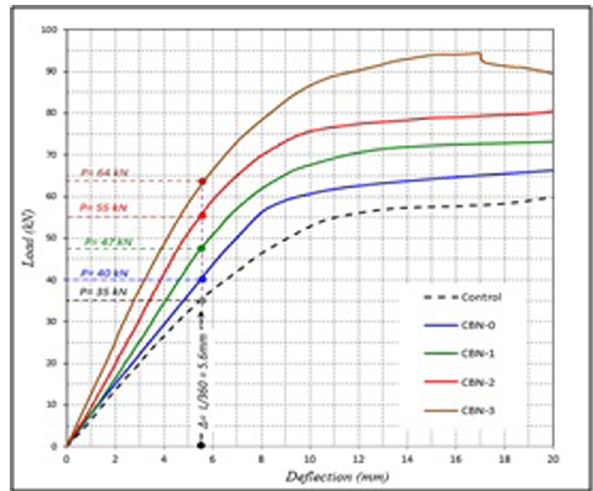
Figure 17: Allowable load at maximum de fl ection ( L/360 ) according to IBC.